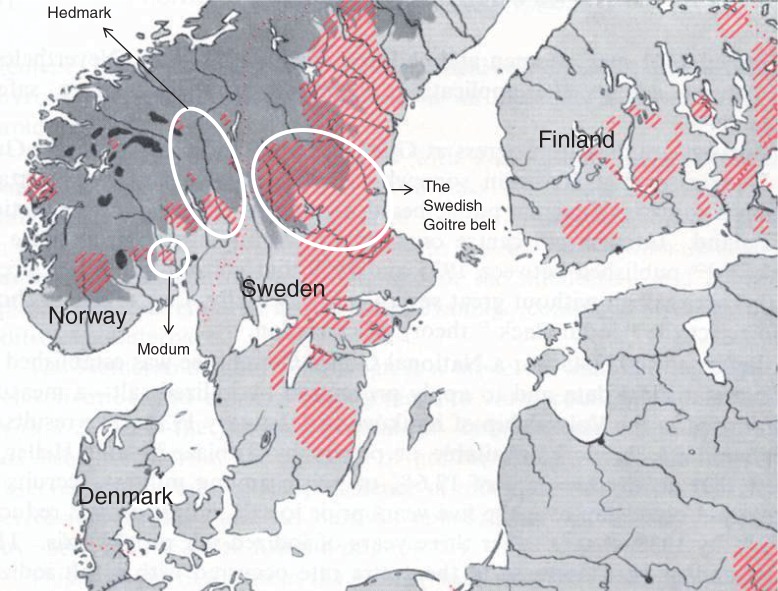
Map of the Nordic countries (except Iceland) in 1960 (55). Dark gray represents mountain areas and striped areas are goiter regions. Sweden still has large areas of goiter 24 years after the start of the iodization program and the salt iodine content was increased in 1966. Goitrous areas are also seen in Norway and Finland.